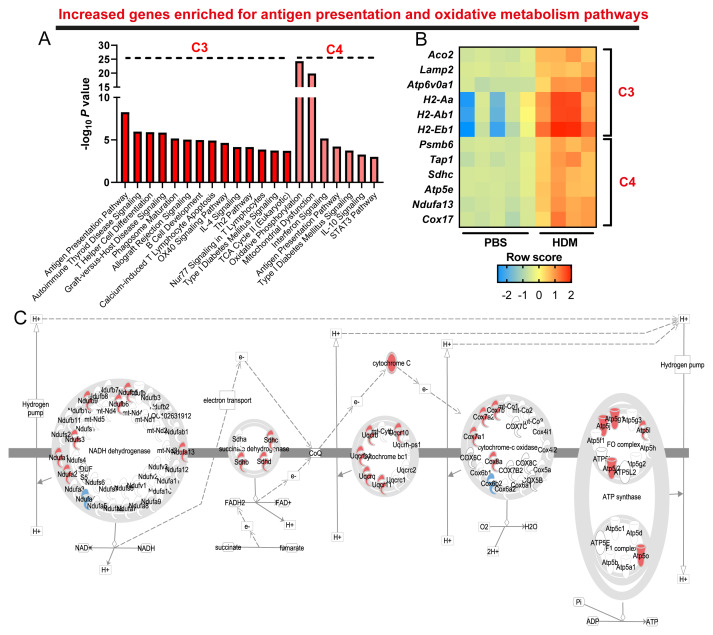
Increased expression AM
HDM gene clusters enriched for antigen presentation and oxidative metabolism pathways.(
A) Highly enriched pathways for clusters of increased genes in AMs
HDM with pathway annotations related to antigen presentation and oxidative metabolism. (
B) Expression of representative genes for clusters and pathway annotations shown in (
A). (
C) Pathway diagram for ‘Oxidative Phosphorylation’ with AM
HDM differential gene expression overlaid. Significantly increased genes are shown in red and decreased genes in blue (FDR-adjusted
P <0.01, fold change ≥2). Bar plot shows canonical pathway names and inverse enrichment Fisher’s exact
P values. Heatmap shows row-centred gene expression values (N=5 mice, PBS; N=4 mice, HDM).